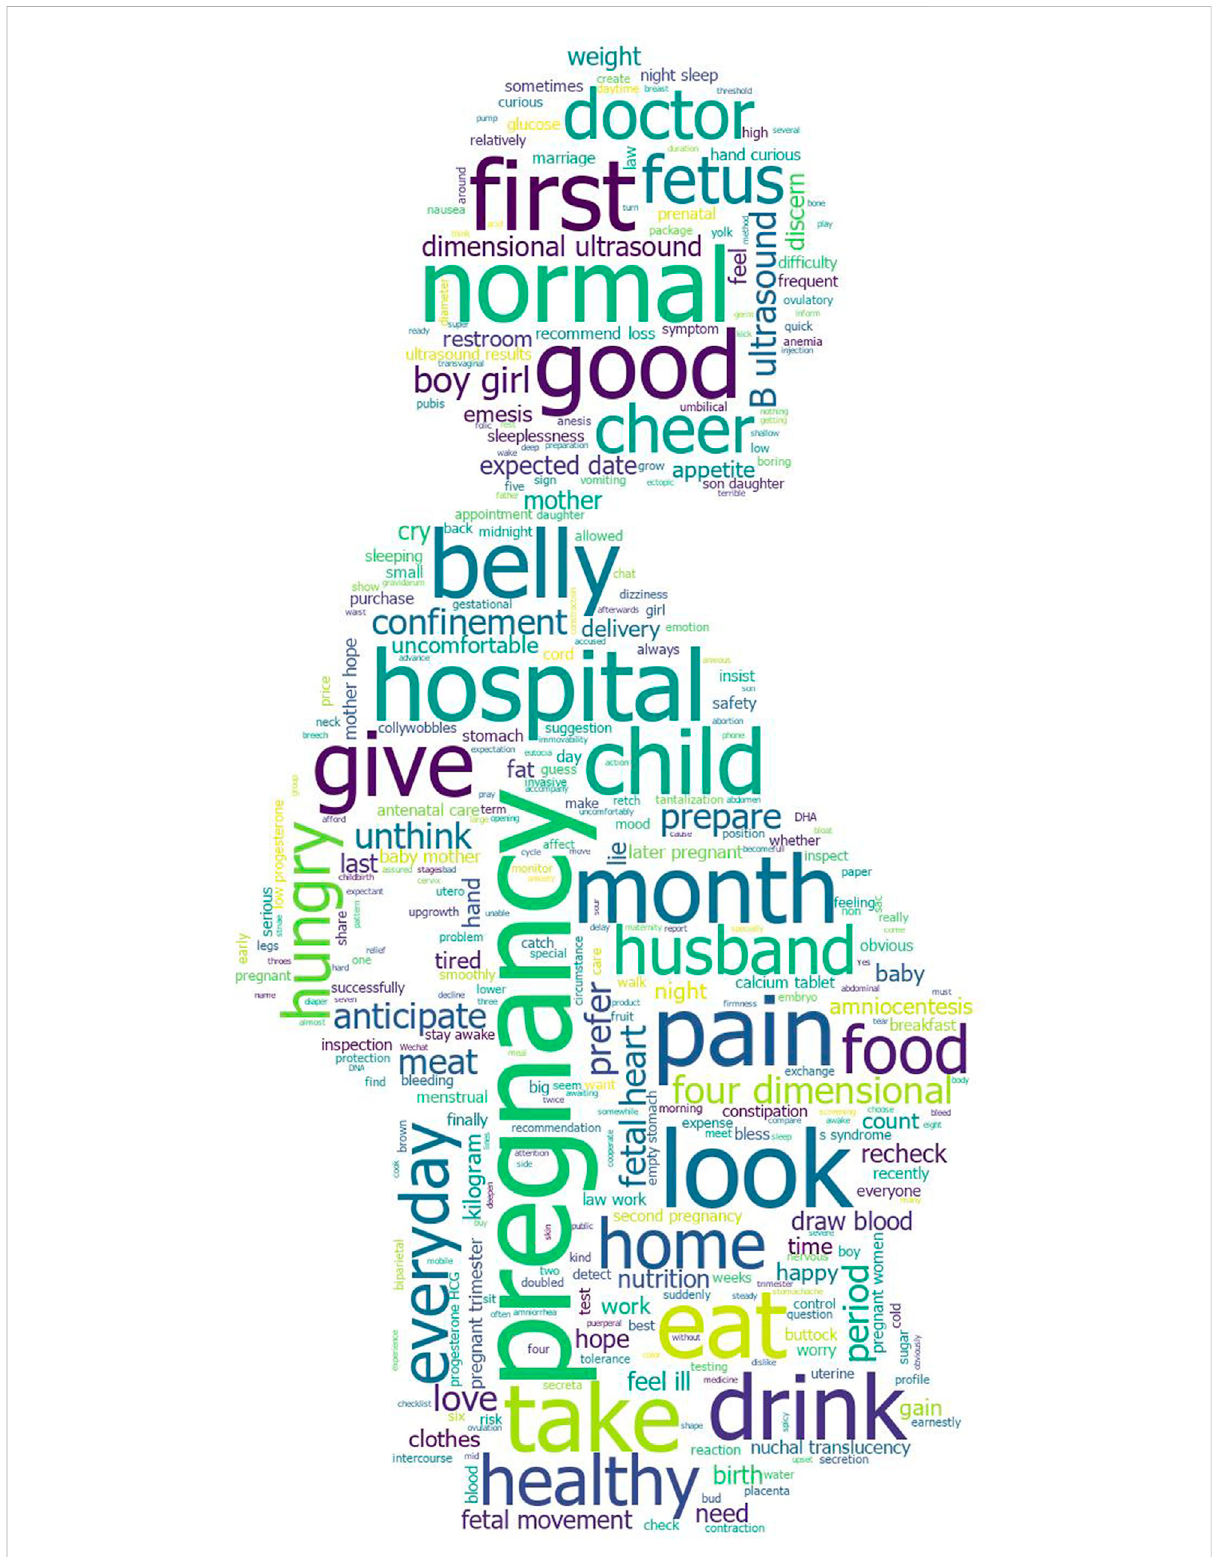
FIGURE 2 The results of word cloud